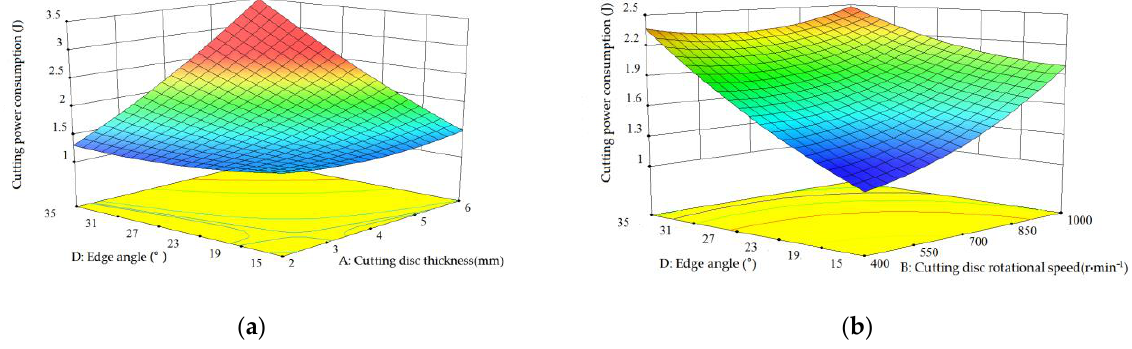
Figure 6. Influence of interactive factors on cutting power consumption.